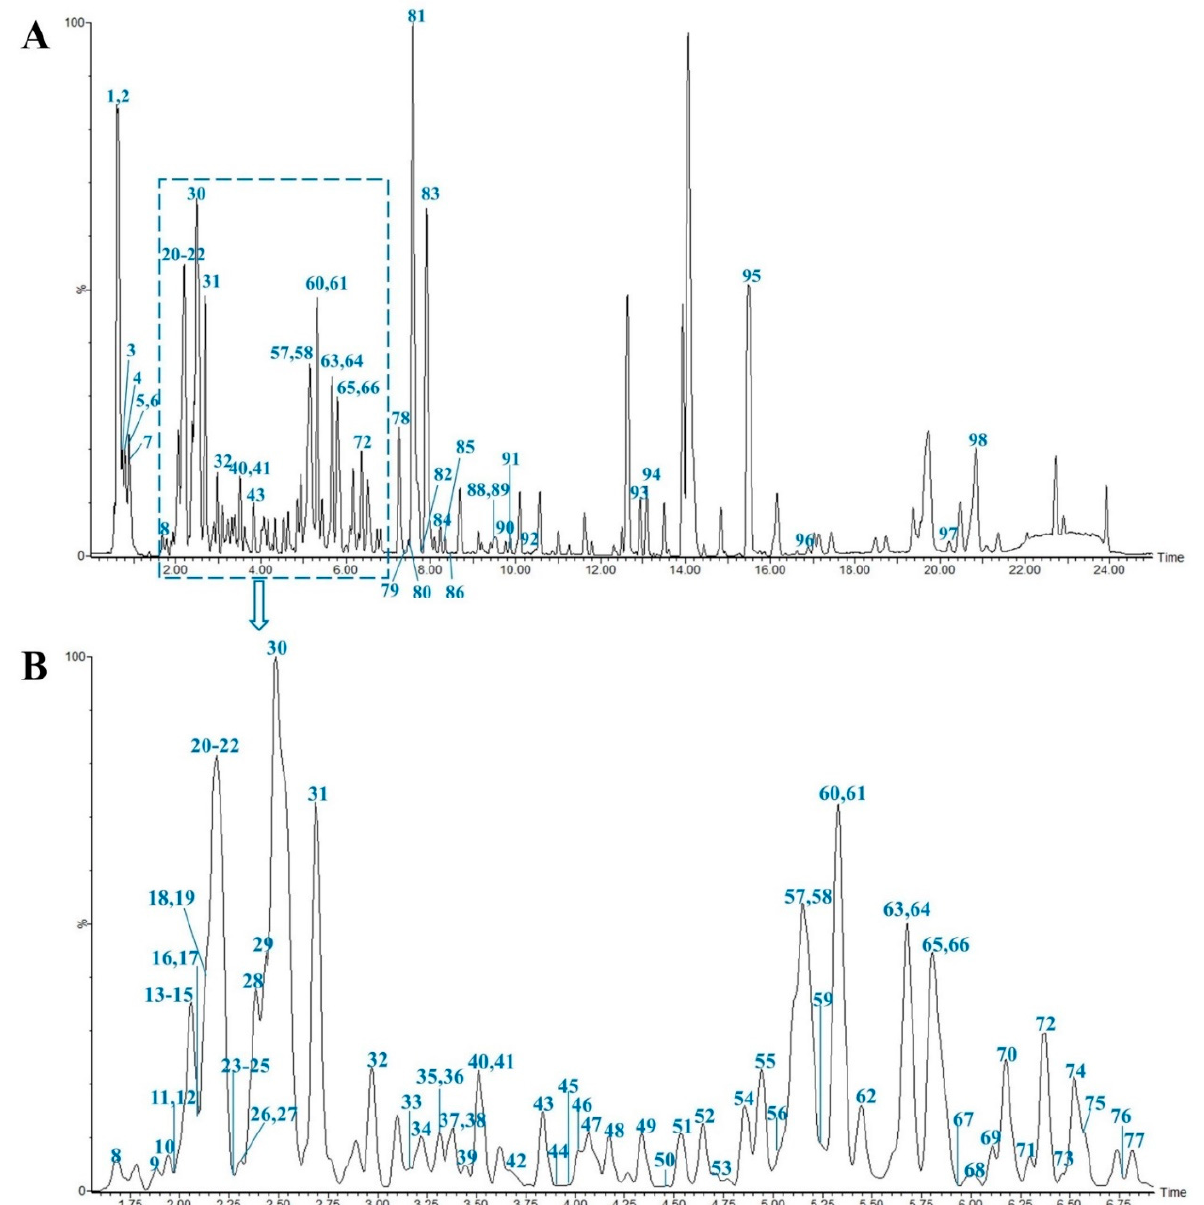
Figure 1. Representative base peak intensity chromatogram of Ophiopogonis Radix in the negative ion mode. The main chromatogram ( A ) and its enlargement ( B ). Peak 42 (Rt = 3.65 min) was taken as an example to elucidate the detailed fragmenta- tion pathway of steroidal saponins. Figure 3 displayed its MS/MS spectra and potential fragmentation pathway. Peak 42 exhibited the [M+HCOO] − ion at m/z 931.4560 with molec- ular formula C 44 H 70 O 18 . Its MS/MS spectrum produced [M-H] − ion at m/z 885.4495 and fragment ions at m/z 753.4206, 607.3493 and 445.2956, corresponding to [M-H-xylose] − , [M- H-xylose-rhamnose] − and [M-H-xylose-rhamnose-glucose] − respectively. Compared with the literature, peak 42 was tentatively characterized as Cixi − ophiopogon C [37]. Two iso- mers (peaks 73 and 77 ) showed [M+HCOO] − ions at m/z 899.4644 with the molecular formula C 44 H 70 O 16 , the fragment ions at m/z 721.4142 and 575.3587, resulting from the loss of a xylose and a successive loss of rhamnose. Based on the fragmentation pattern and the related literature, they were tentatively identified as Ophiopogonin D and Sprengerinin C, respectively